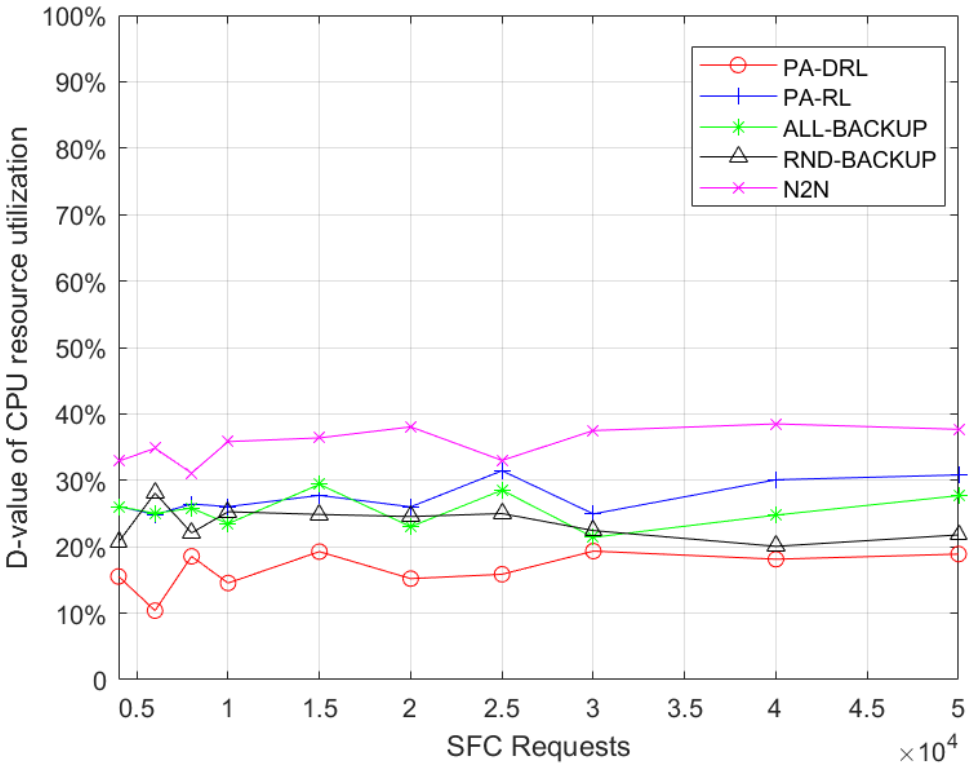
Figure 7. D ‐ value between maximum and average nodes’ resource utilization under each SFC requests number.